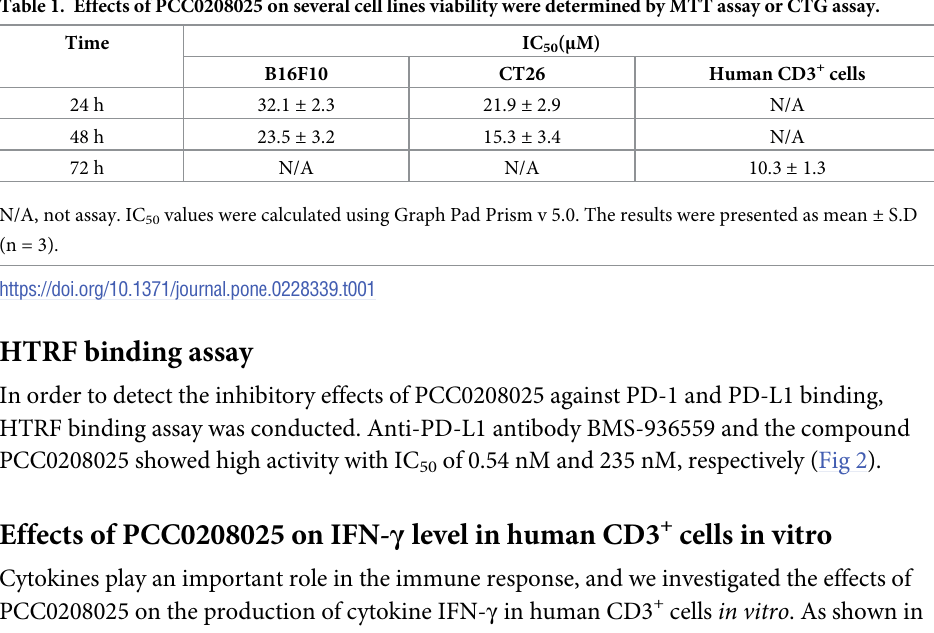
Table 1. Effects of PCC0208025 on several cell lines viability were determined by MTT assay or CTG assay. Time IC 50 ( μ M)